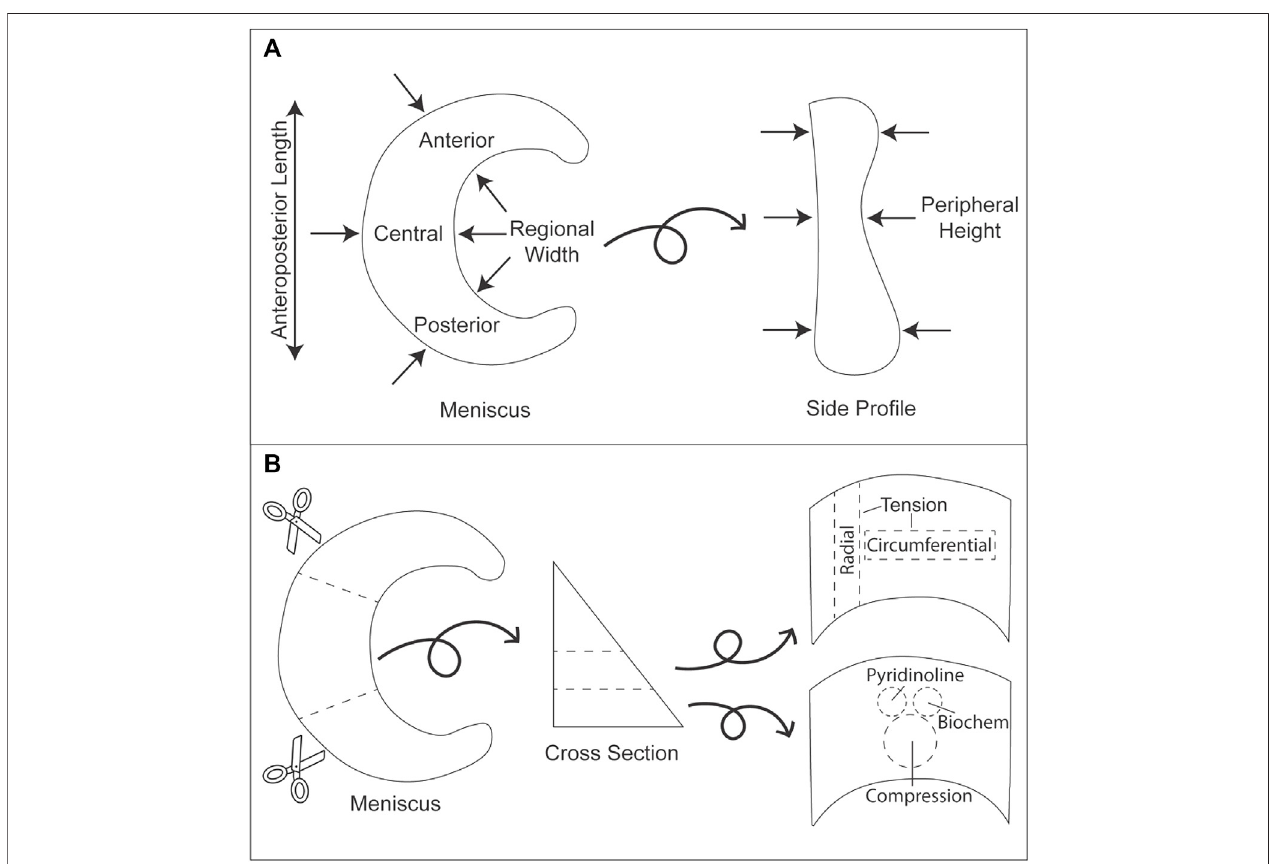
FIGURE 1 | Gross morphology measurements and division of minipig knee menisci for mechanical and biochemical analyses. (A) Arrows indicate the locations where measurements were taken for anteroposterior length, regional width, and peripheral height. (B) Each meniscus was cut into three regions (anterior, central, posterior). Subsequently, each section was cut into layers from which tensile (circumferential and radial directions), compressive (creep indentation), biochemistry, and mass spectrometry samples were